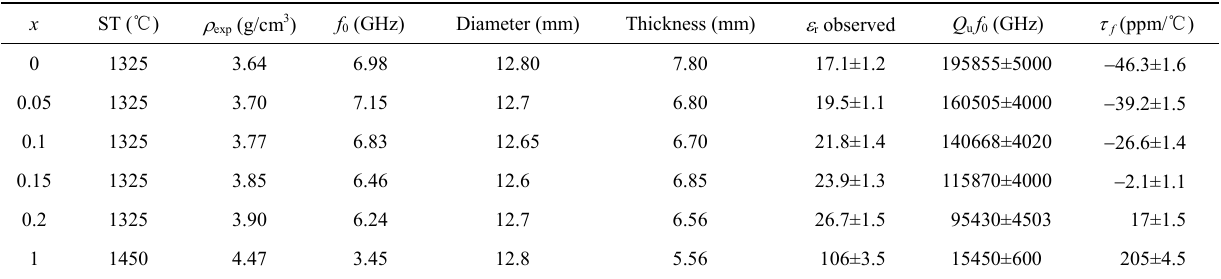
Fig. 6  of (1 − x )Mg 0.95 Ni 0.05 Ti 0.98 Zr 0.02 O 3 – x Ca 0.6 - f La 0.8/3 TiO 3 (0 ≤ x ≤ 0.2) ceramics as a function of x value. Table 2 Preparation conditions, experimental densities, and microwave dielectric properties of (1 − x )Mg 0.95 Ni 0.05 Ti 0.98